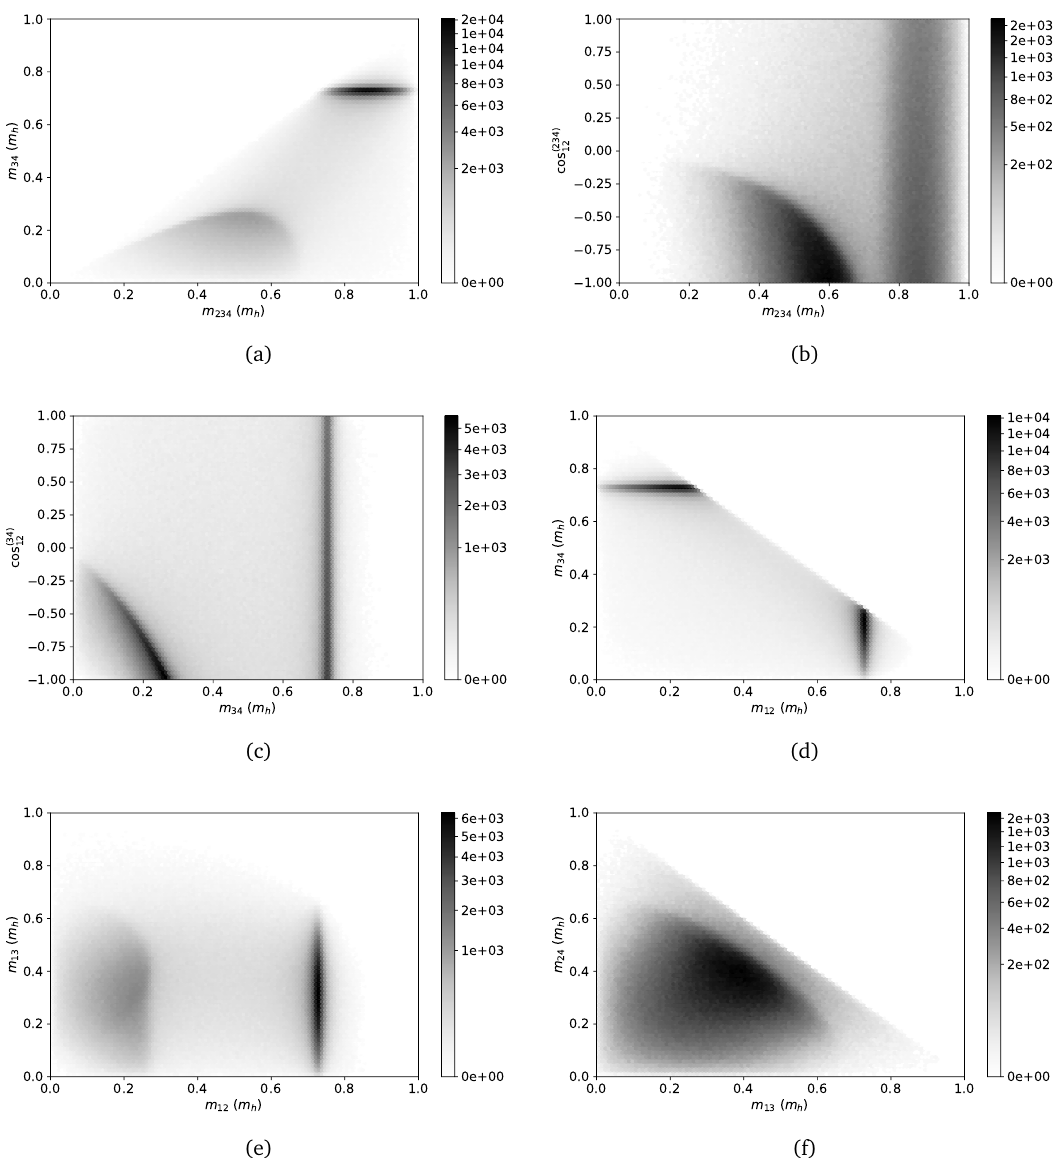
Figure 6: Density plots of 2.6 × 10 6 points generated by the ANN (after unweight- ing). Plotted kinematic variables are aligned with coordinates on the target-space hypercube, with the exception of m